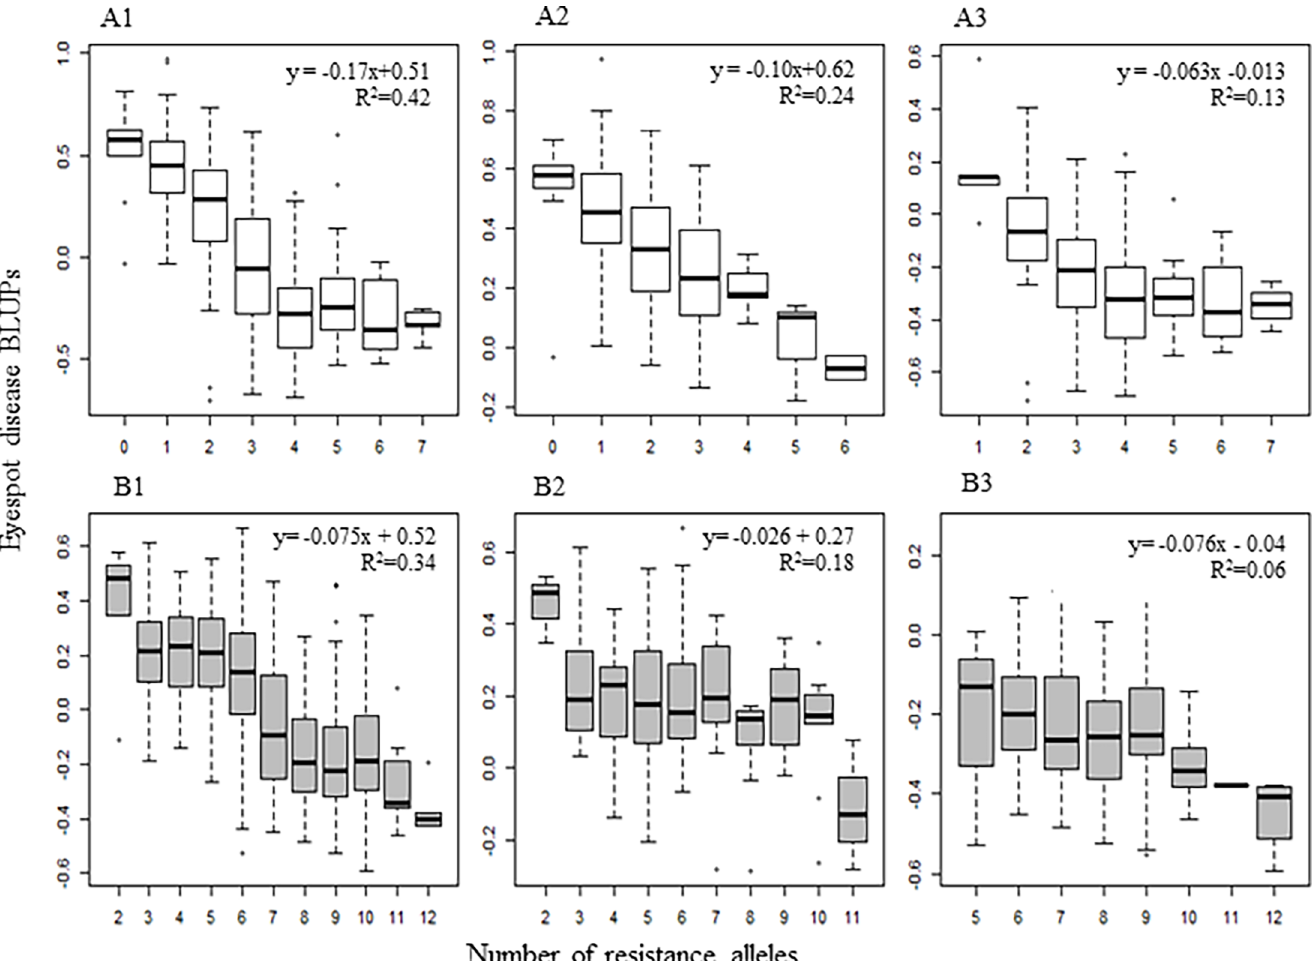
Fig 4. Boxplots of eyespot disease BLUPs for the number of resistance alleles for the most significant tagging markers in all winter wheat lines in Panel A (469 lines) (A1), lines in Panel A without the Pch1 (164) (A2) and lines in Panel A with Pch1 (253) (A3); all lines in Panel B (399) (B1), lines in Panel B without Pch1 (143) (B2) and Panel B lines with Pch1 (168)